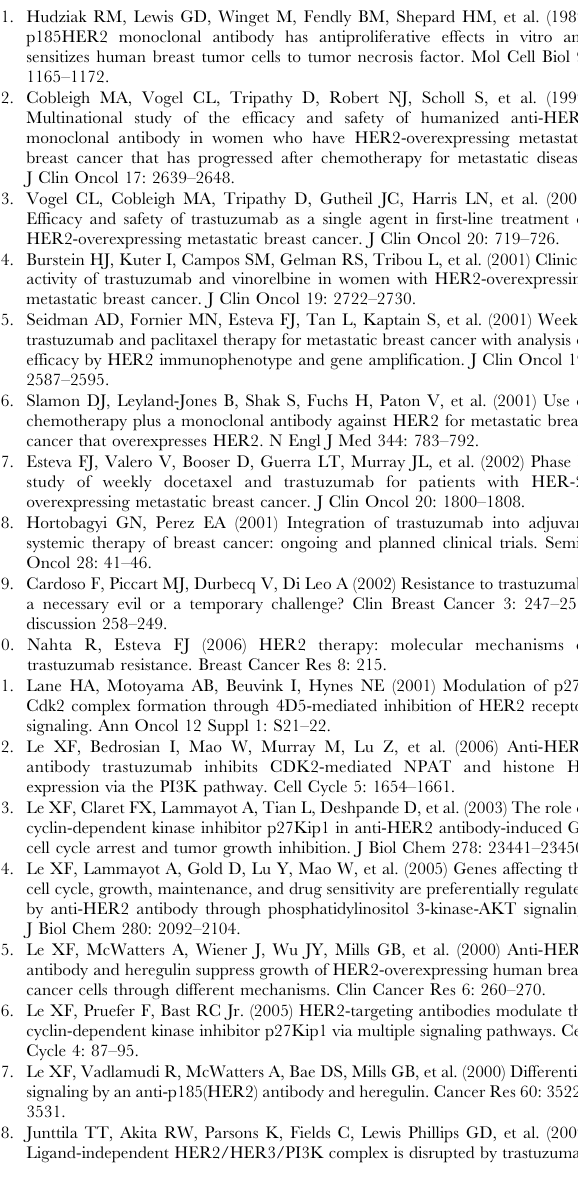
Figure S1 Heatmap of the differentially expressed miRNAs in response to trastuzumab treatment in HER2-overexpressing SKBr3 cells (A) and BT474 cells (B). To visualize the clusters of expressed miRNAs after trastuzumab treatment, hierarchical clustering was performed based on the differentially expressed miRNAs. Names of samples (top) and miRNAs (side) is shown by using One Minus Correlation as a distance measure after genes centering and scaling, and average linkage method for defining the distance between the clusters. Sample BRC20, SKBr3 cells treated control hIgG for 20 hrs; BRHCT20, SKBr3 cells treated trastuzumab for 20 hrs; BTC48, BT474 cells treated with control hIgG for 48 hrs;